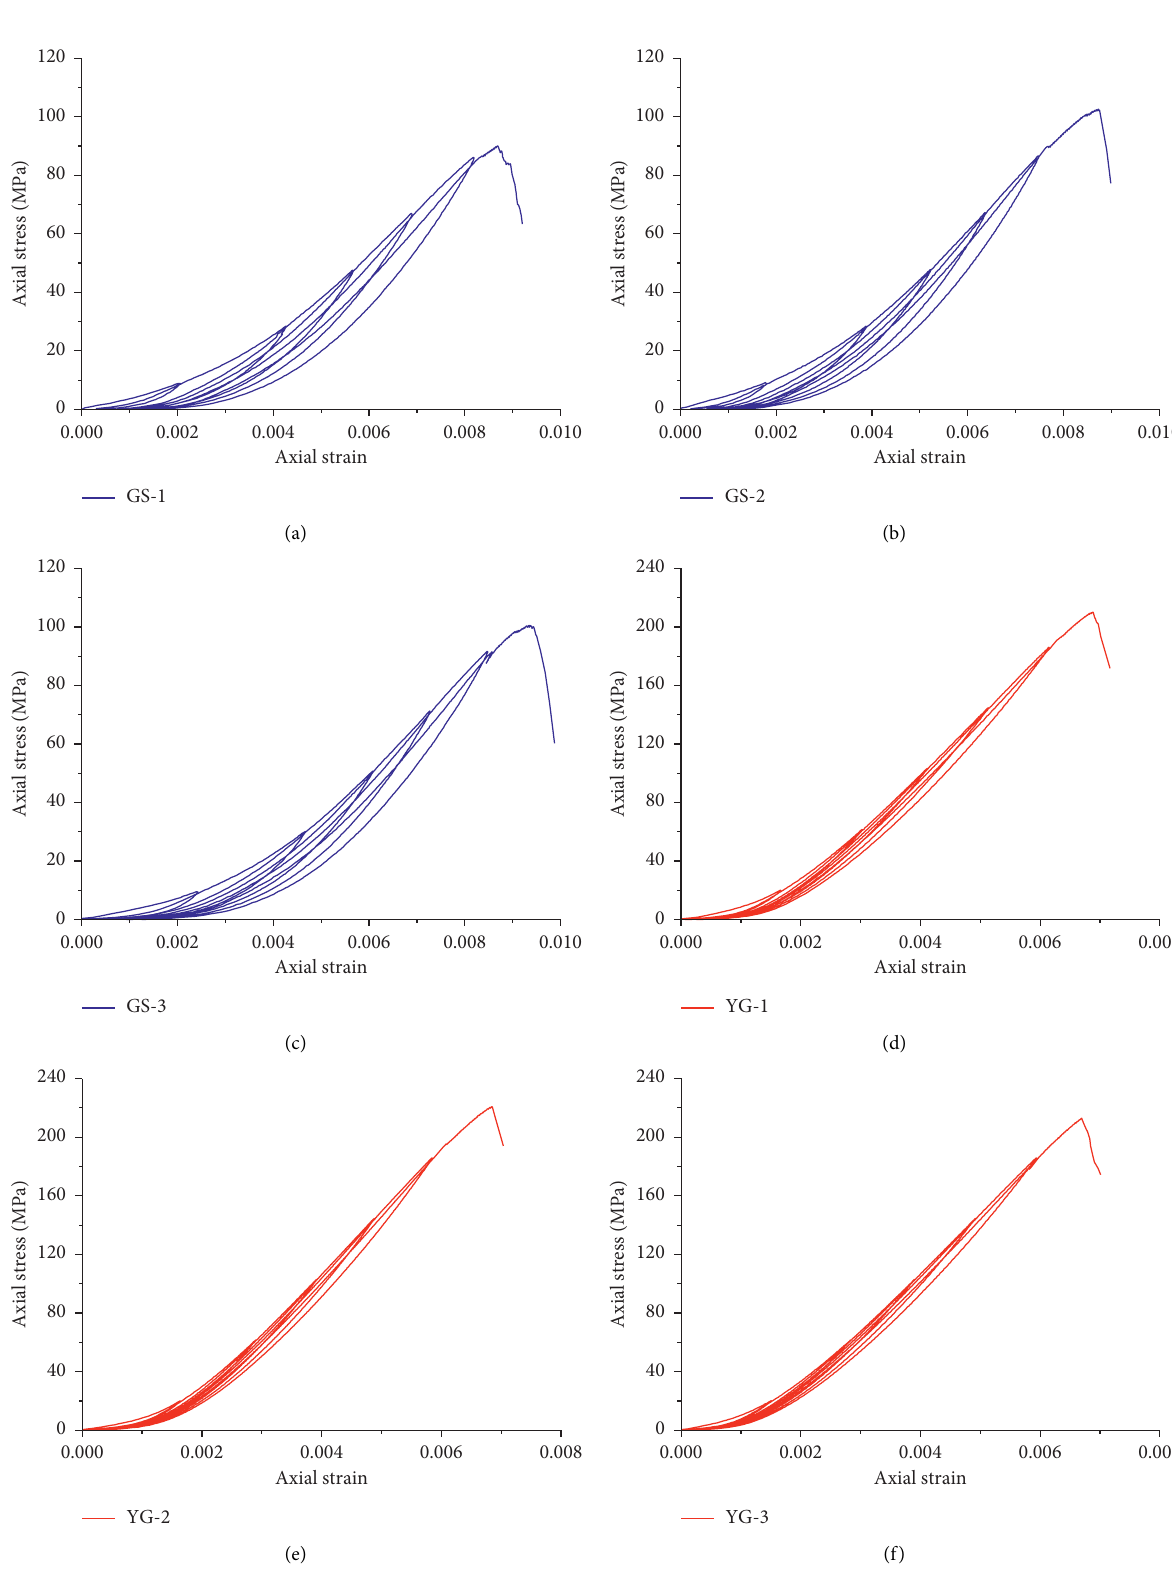
Figure 4: Stress-strain curve of the rock specimen in cyclic loading-unloading tests. (a) GS-1; (b) GS-2; (c) GS-3; (d) YG-1; (e) YG-2; (f)